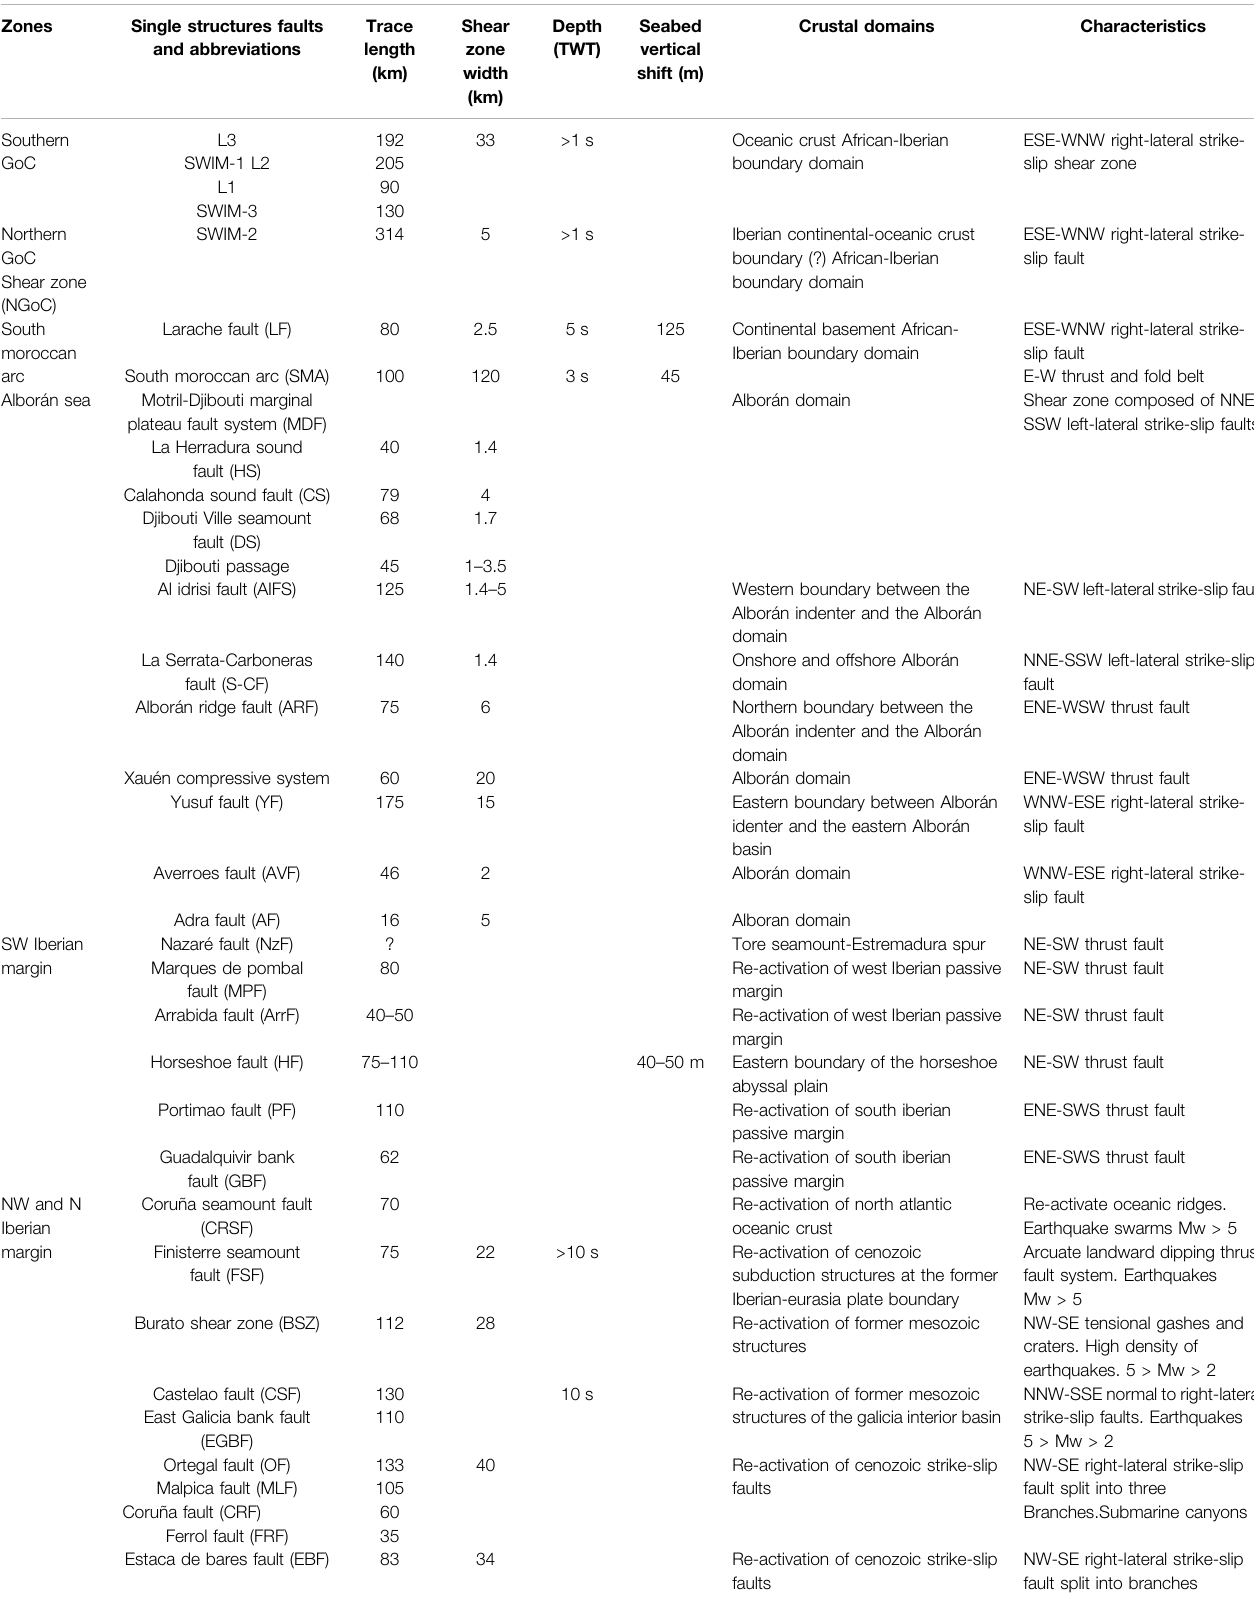
TABLE 1 | List of active submarine faults and